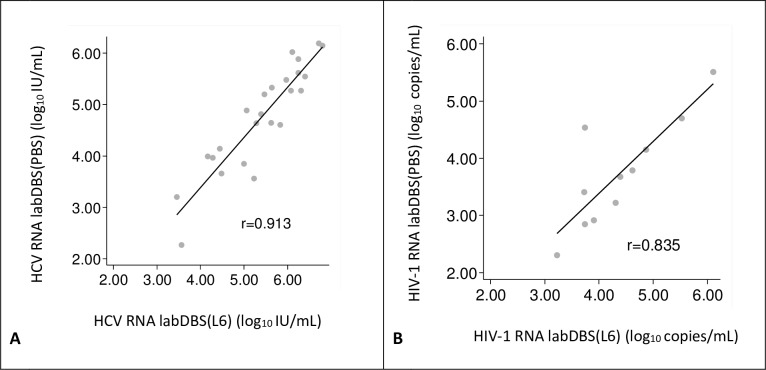
Correlation between viral load measurements of laboratory sampled DBS (labDBS) eluted in L6-buffer and PBS.Individual viral load measurements are plotted (gray dots). The solid line indicates the linear regression line between the two samples. (A) HCV loads. The linear relationship between the samples is defined as: log10 IU/mL labDBS (PBS) = 0.978*log10 IU/mL labDBS (L6) –0.534. (B) HIV-1 loads. The linear relationship between the samples is defined as: log10 copies/mL labDBS (PBS) = 0.910*log10 copies/mL labDBS (L6)– 0.252. DBS (PBS) = DBS eluted in PBS, DBS (L6) = DBS eluted in L6.